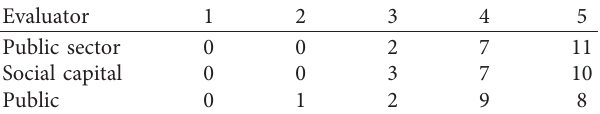
Table 6: Evaluation